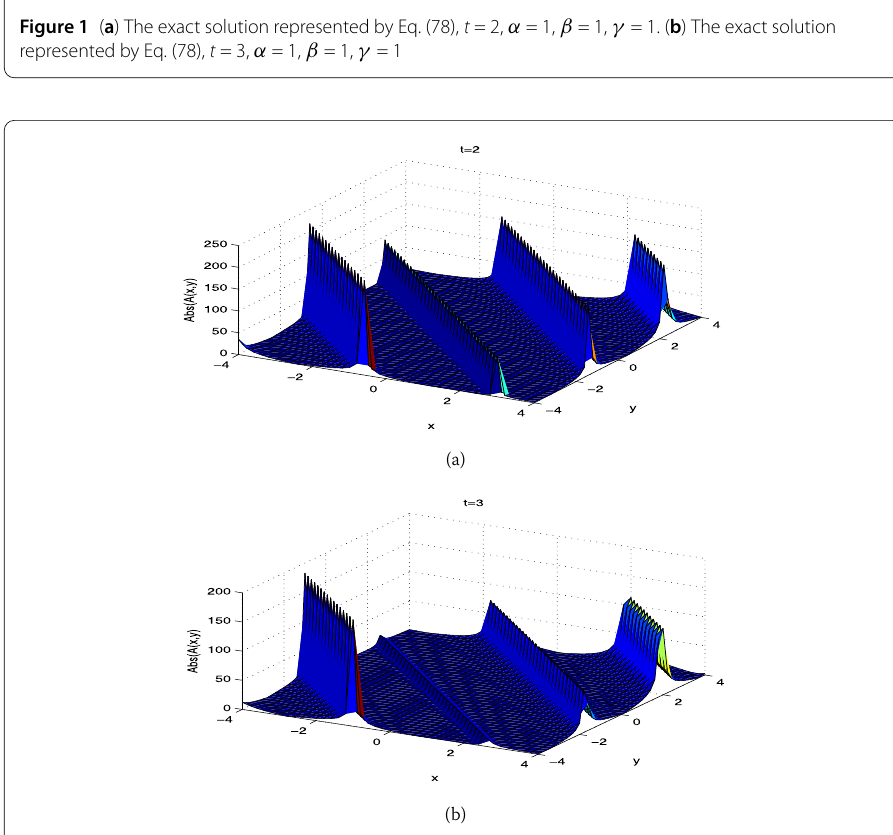
Figure 2 ( a ) The exact solution represented by Eq. (78), t = 2, α = 0.5, β = 1, γ = 1. ( b ) The exact solution represented by Eq. (78), t = 3, α = 0.5, β = 1, γ =